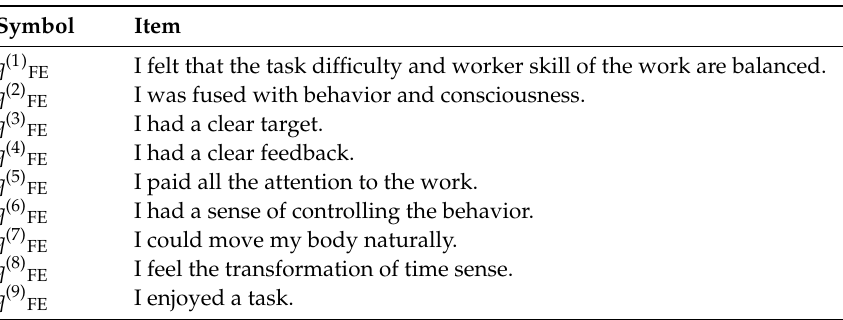
Table 1. Item of flow state